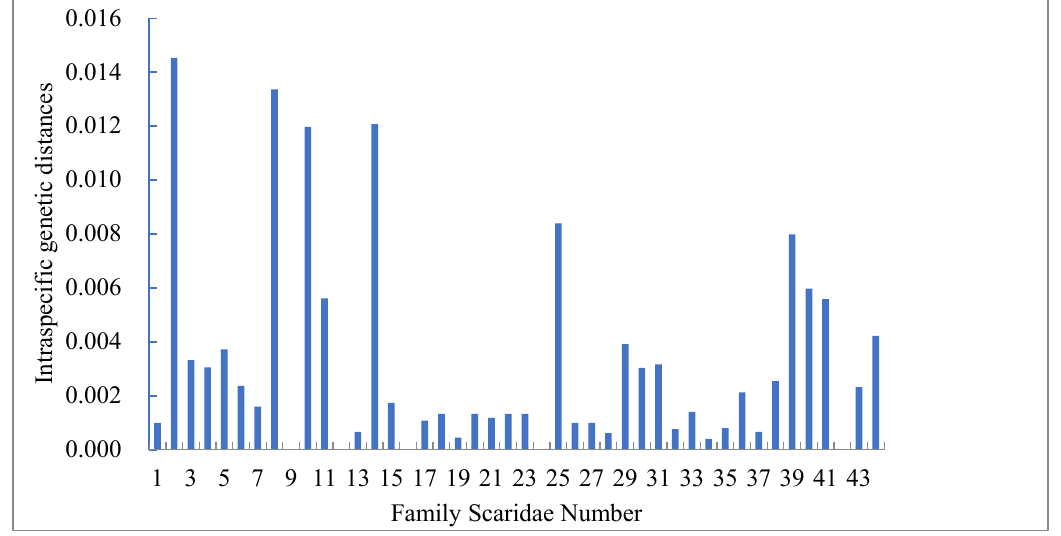
Figure 1. The intraspecific genetic distances of the family Scaridae . Note: The abscissa represents the species: 1 . Bolbometopon muricatum , 2. Cetoscarus ocellatus , 3. Hipposcarus longiceps , 4. Scarus iseri , 5. S. rubroviolaceus , 6. S. ghobban , 7. S. taeniopterus , 8. S. niger , 9. S. forsteni , 10 . S. prasiognathos , 11. S. frenatus , 12. S. dimidiatus , 13 . S. oviceps , 14. S. chameleon , 15. S. rivulatus , 16. S. globiceps , 17. S. quoyi , 18 . S.